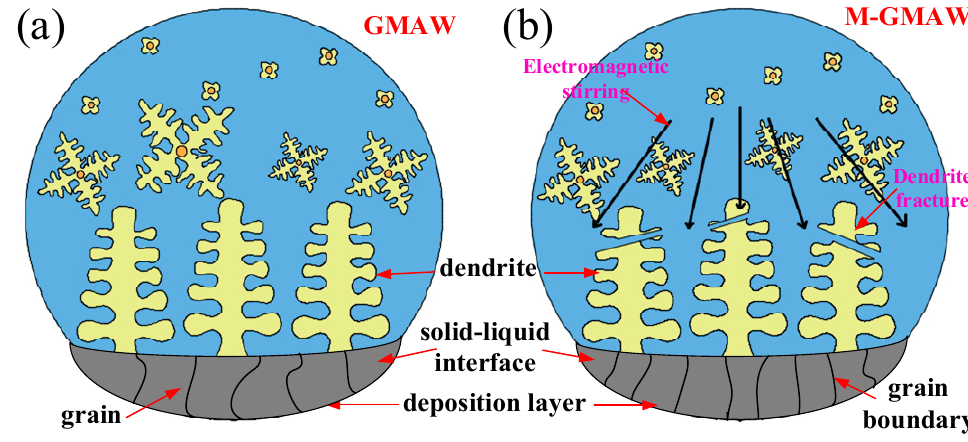
Figure 9. ( a , b ) Grain refinement under the action of electromagnetic stirring.